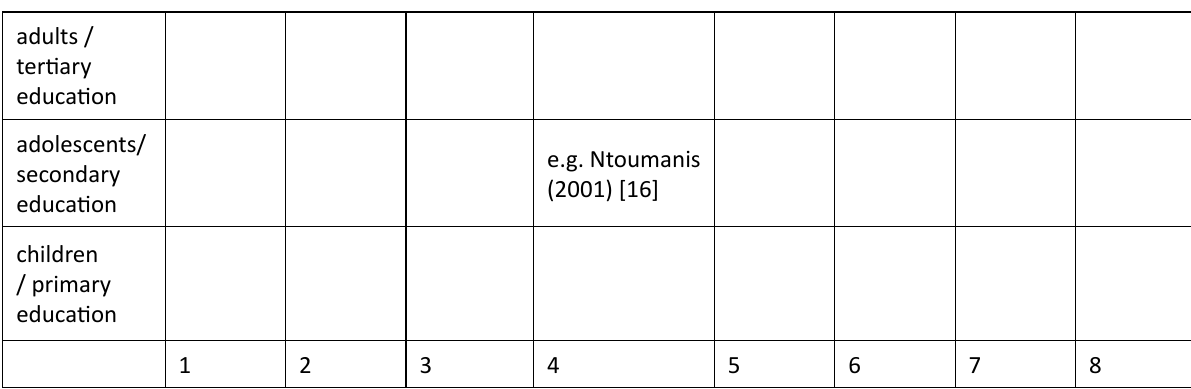
Figure 7. Two dimensional matrix mapping the conceptual structure of the physical education research field: Source: Own study based on combination of findings from co-word analysis [2] and direct citation